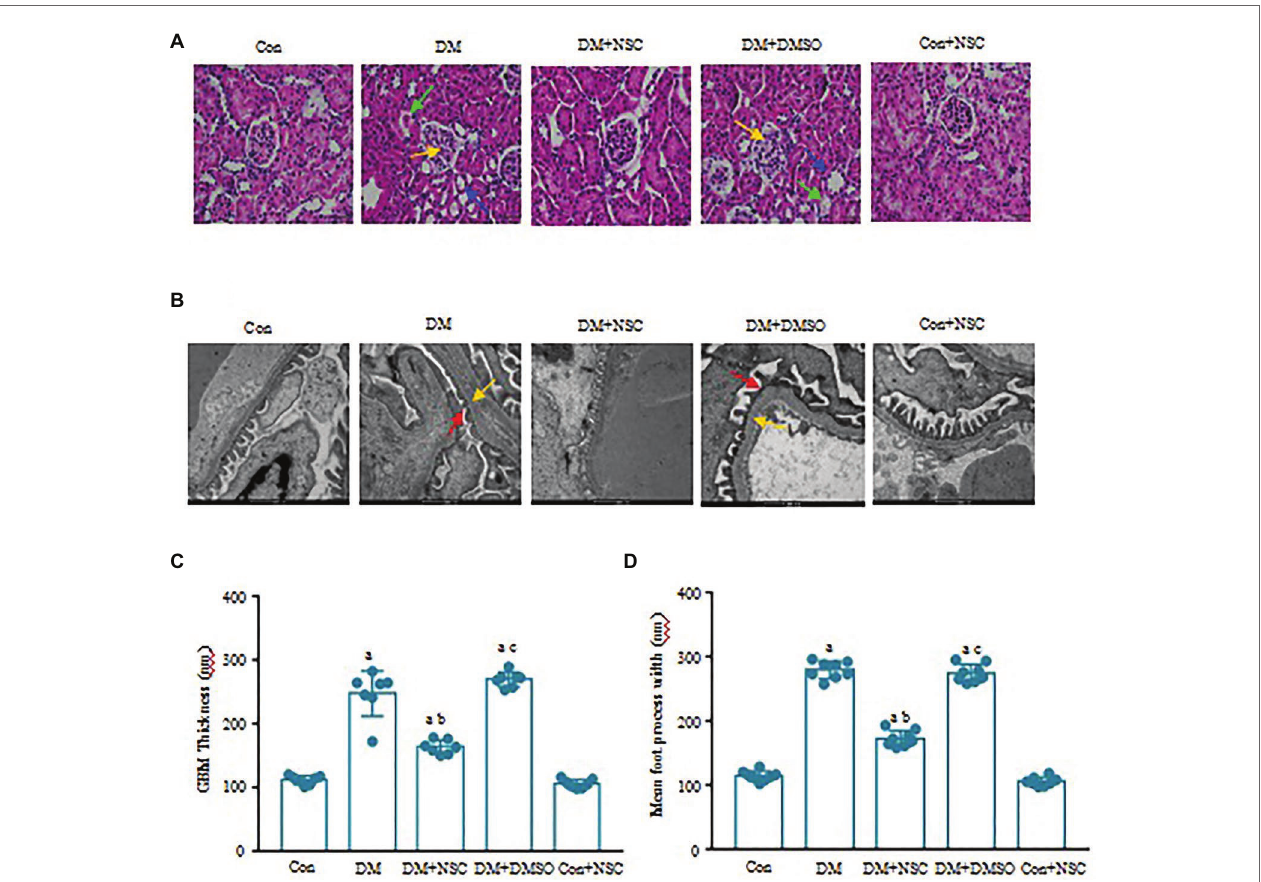
FIGURE 3 | Effect of RAC1 inhibition on glomeruli. (A) Assessment of renal morphological changes. Representative photomicrographs of H&E staining are shown. Yellow arrows show glomerular capillary disorder, blue arrows show renal tubule atrophy, and green arrows show vacuolar degeneration. The scale bar is 50 μ m (magnification × 40). (B) Representative photographs of glomeruli. Red arrows show chorion fall out, and yellow arrows show basement membrane. The scale bar is 500 nm (magnification × 4,000). (C) The thickness of the glomerulus basement membrane in each group. (D) Width of the foot processes. Values denote the mean ± SD. a p < 0.05 vs. the Con group; b p < 0.05 vs. the DM group; c p < 0.05 vs. the DM + NSC group. n = 7 from four mice in each